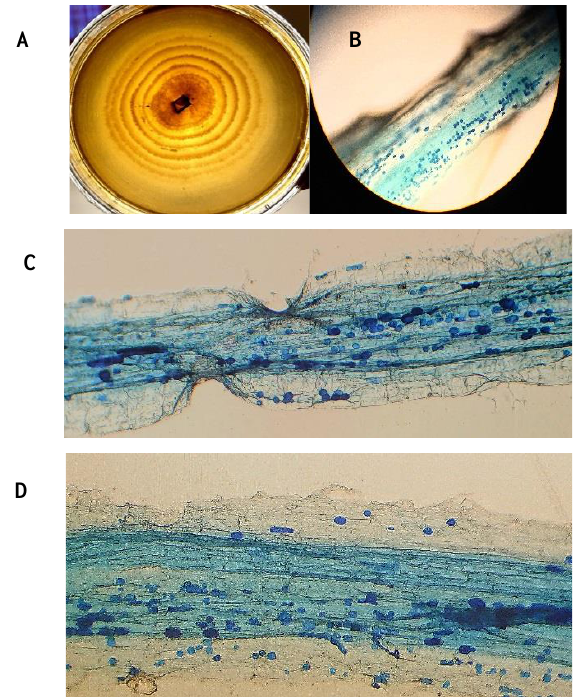
Fig. 2 The growth of S. indica in modified Kaefer medium and representative microscopic view of the S. indica